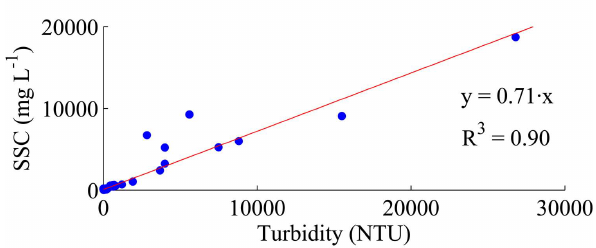
Fig. 2. Linear regression relation between SSC and turbidity in 1 station, from available data of the JA